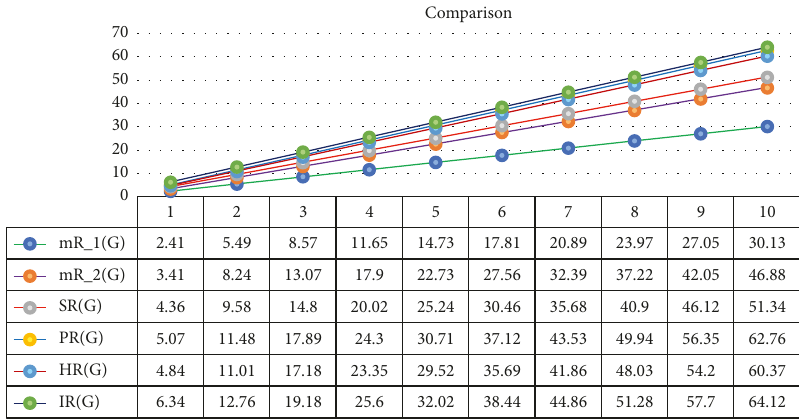
m R 2 ( PF ) , SR ( PF ) , PR ( PF ) ,